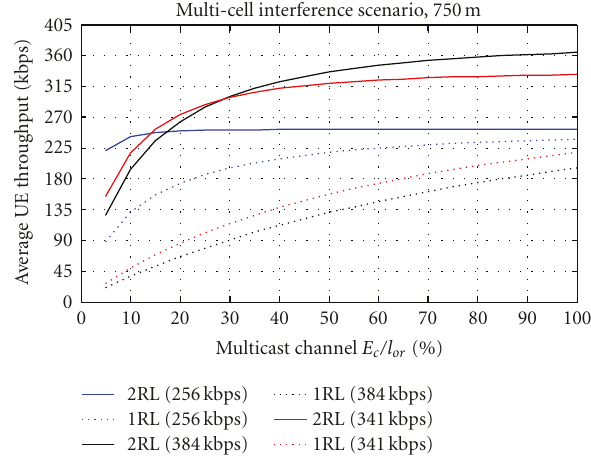
Figure 16: Throughput versus E c /I or , k = 0 . 4.